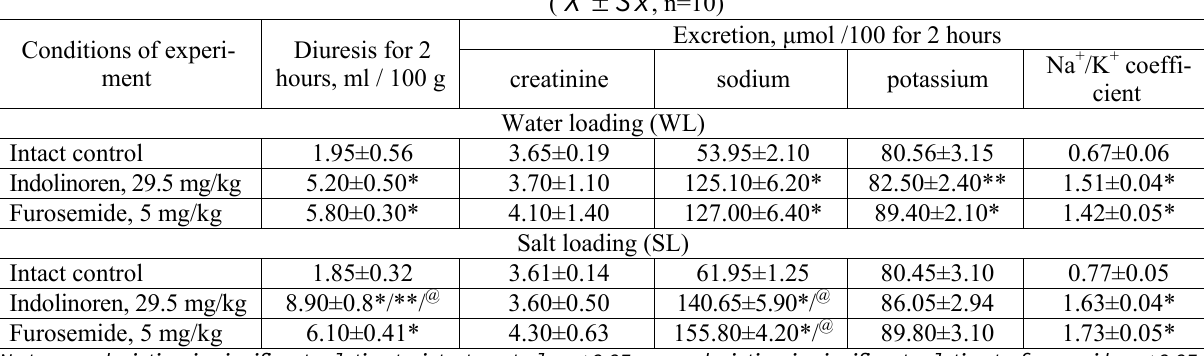
Influence of indolinoren on diuresis and electrolyte excretion under the conditions of water and salt